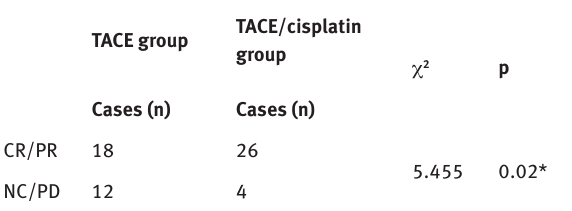
Figure 3 Number of cases with IM (intrahepatic metastasis), UGB (upper gastrointestinal bleeding) and LF (liver failure) in the TACE group and the TACE/cisplatin